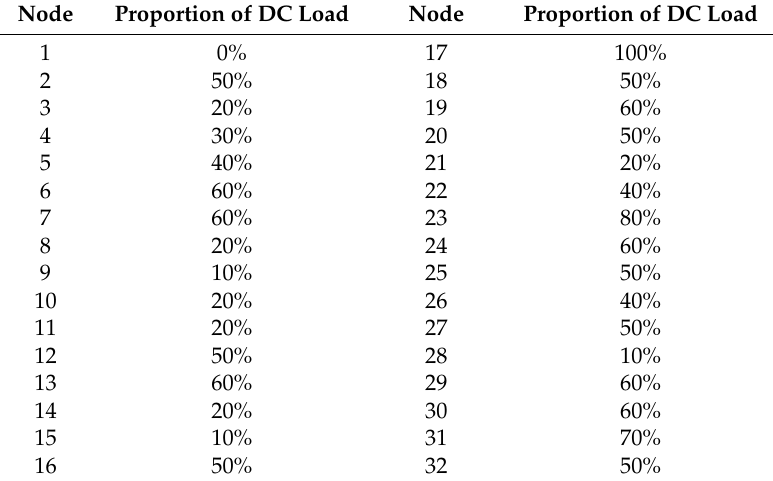
Table 2. The proportion of the direct current (DC) load of each node.